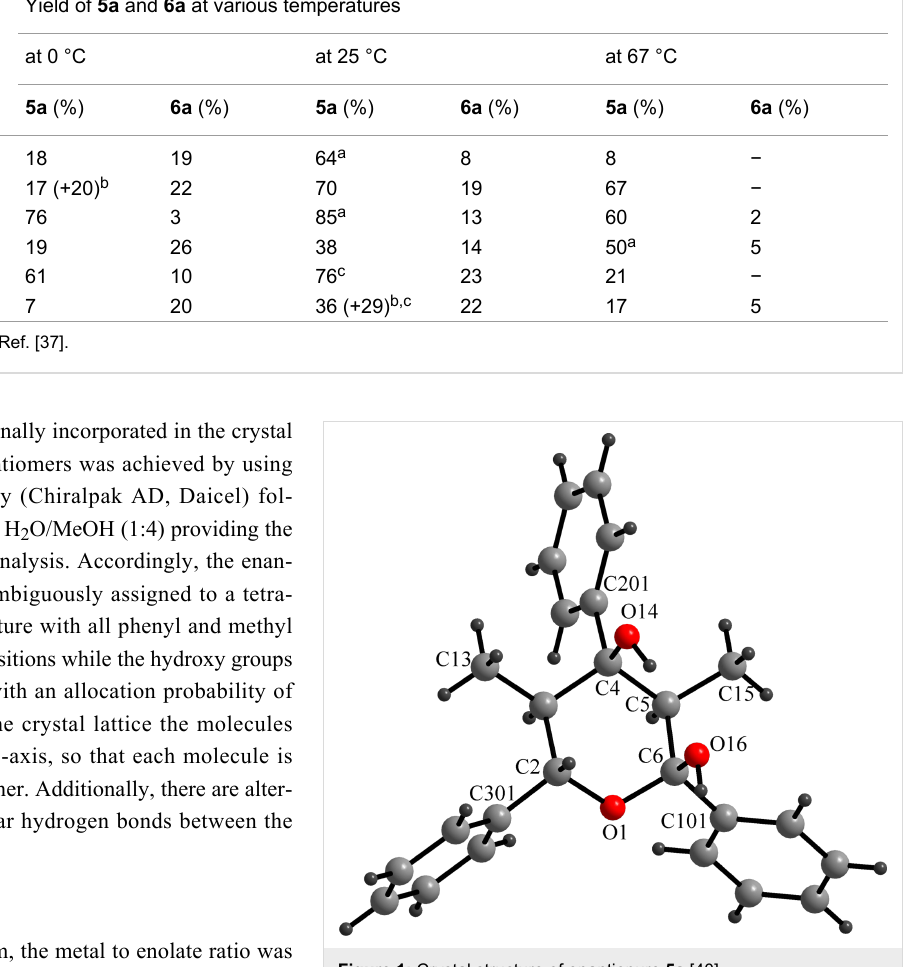
enolate had different effects on the reactions depending on the metals. While the yield was decreased with zirconium, it in- creased both with aluminum and indium. In the latter case, >99% yield was